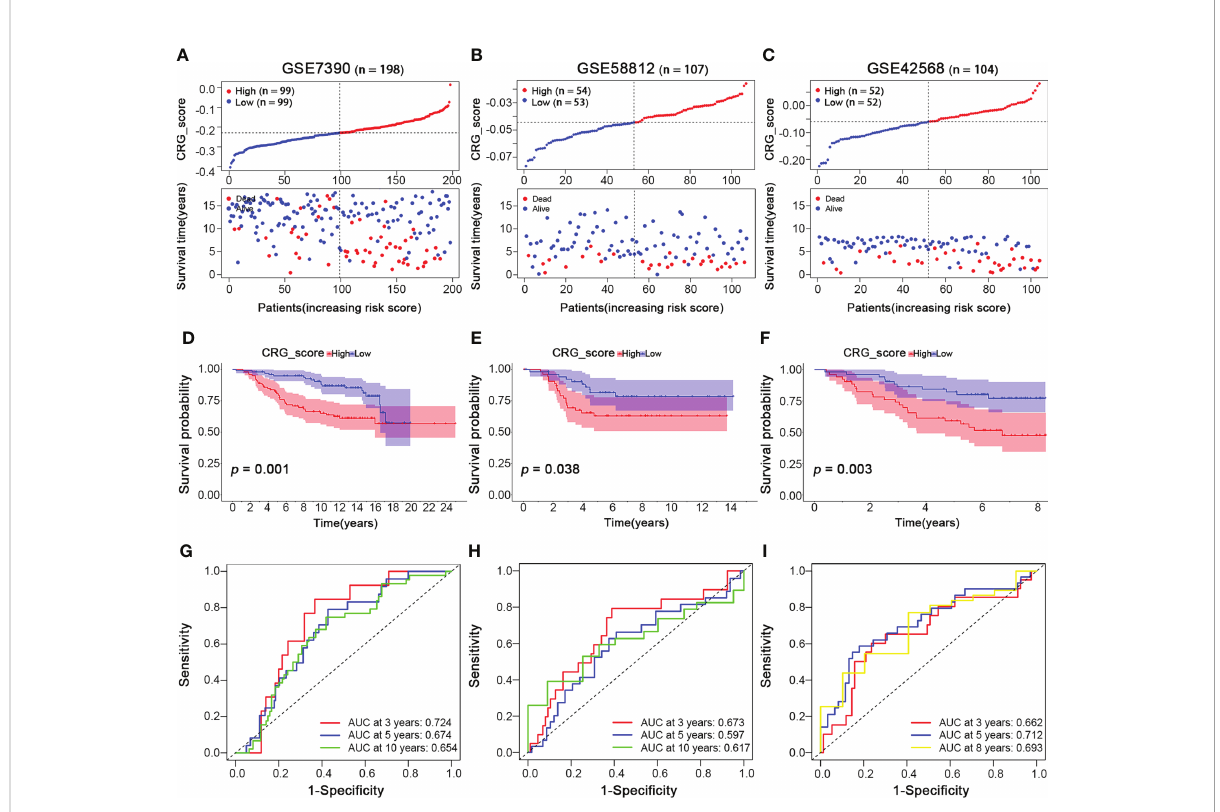
FIGURE 7 Validation of the Cuproptosis-Related Gene Signature in BRCA Testing Cohorts. BRCA Testing Cohorts: GSE7390 (n = 198), GSE58812 (n = 107), and GSE42568 (n = 104). (A – C) The ranked dot and scatter plots of CRG_score distribution and patient survival status in BRCA testing cohorts (GSE7390, GSE58812, and GSE42568 sets, respectively). (D – F) The overall survival of the high and low CRG_score groups in BRCA testing cohorts (GSE7390, GSE58812, and GSE42568 sets, respectively). (G – I) The ROC curves for the predictive ef fi ciency of the CRG_score in BRCA training cohort (red: 3 year; blue: 5 year; yellow: 8 year; green: 10